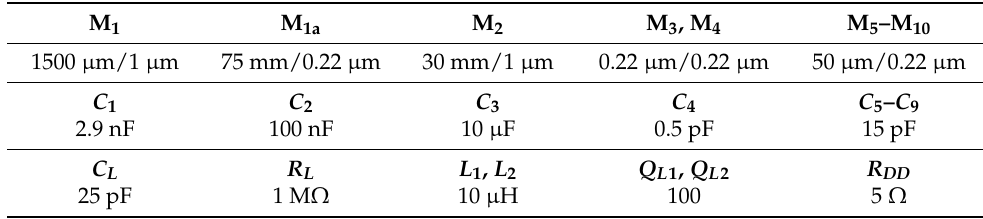
Table 2. Parameters of the starter components.